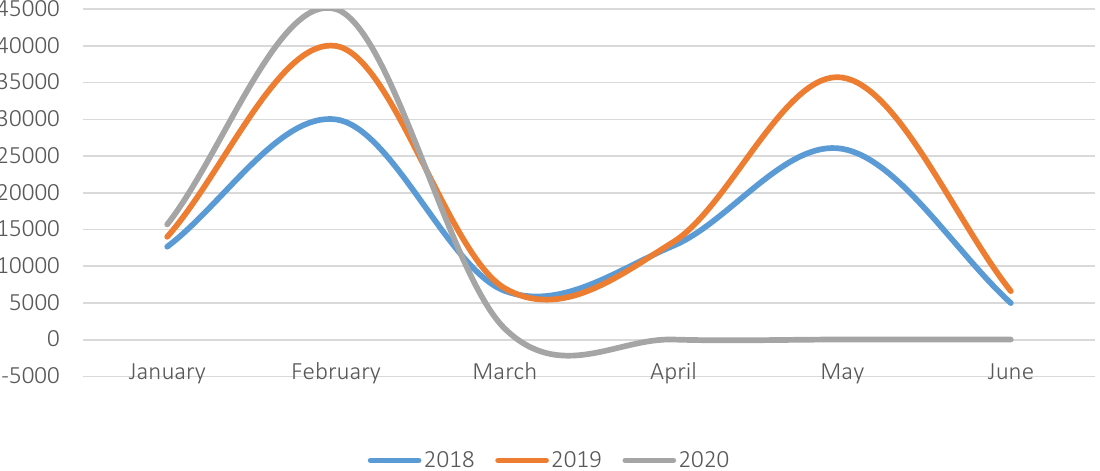
Figure 2. Dynamics of tourist fee for the first half of 2018, 2019, 2020,